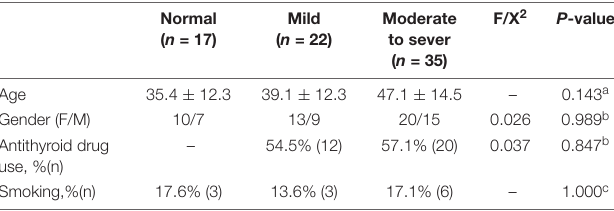
TABLE 1 | Demographics of the control and TAO groups.